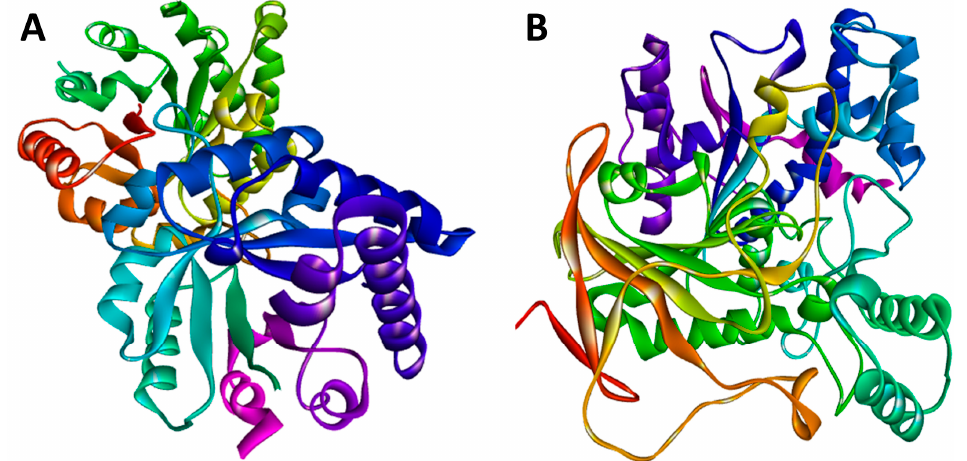
Figure 1. The structural models were predicted using the online SWISS-MODEL tool. ( A ) The three- dimensional (3D) structure for the triose-phosphate isomerase (TIM) of R. microplus (RmTIM); ( B ) The 3D structure for the acetylcholinesterase (AChE1) of R. microplus (RmAChE1).